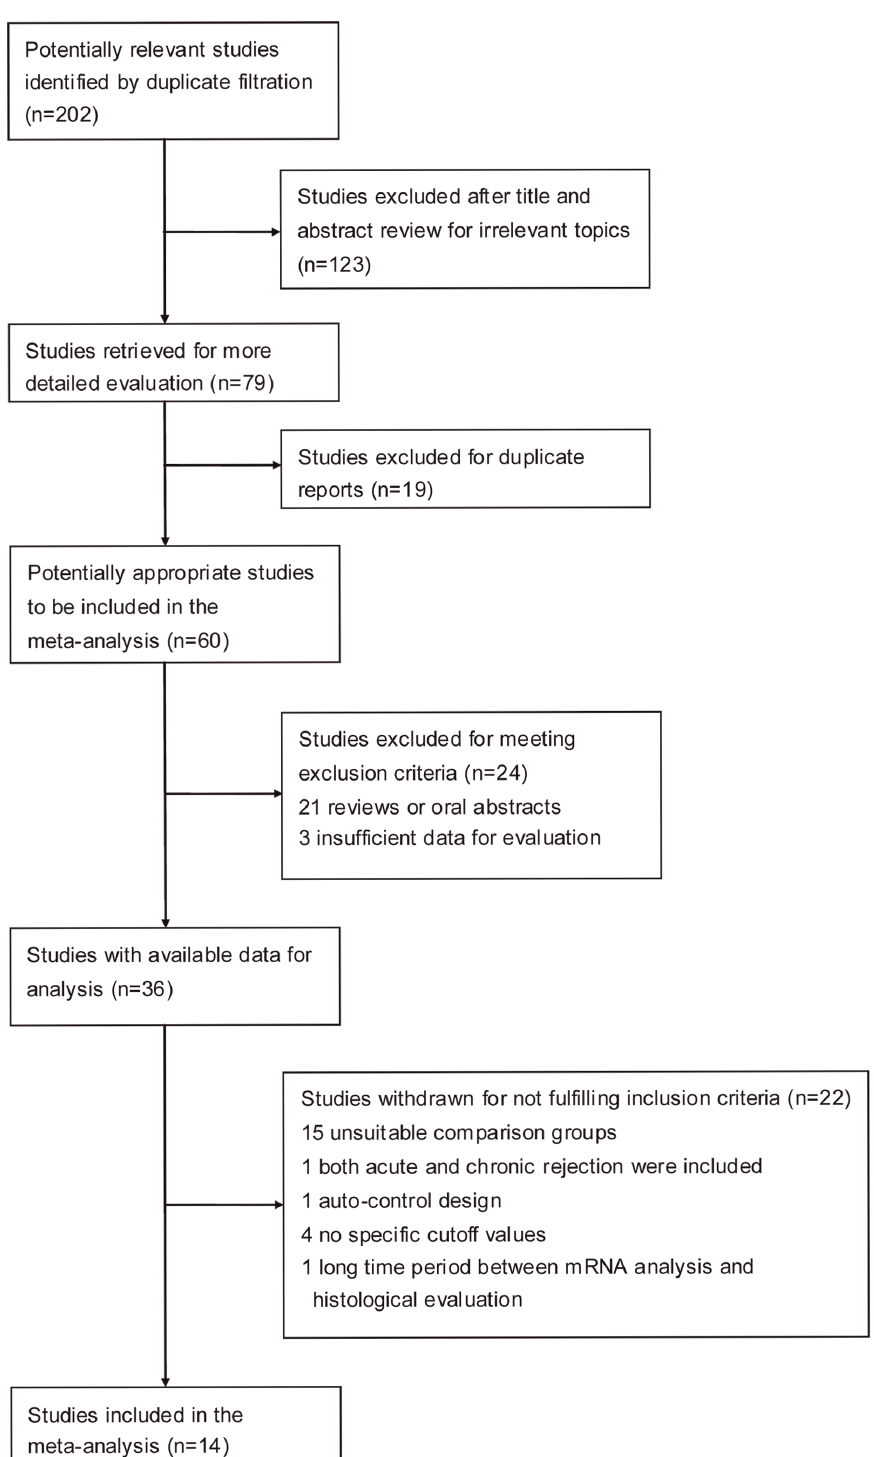
Figure 1. Flow chart describing the literature search conducted for this meta-analysis. doi:10.1371/journal.pone.0039610.g001 Sample origin. The studies were stratified according to the 3